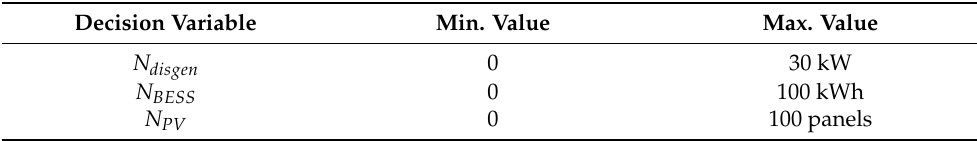
Table 6. Minimum and maximum values of decision variables.